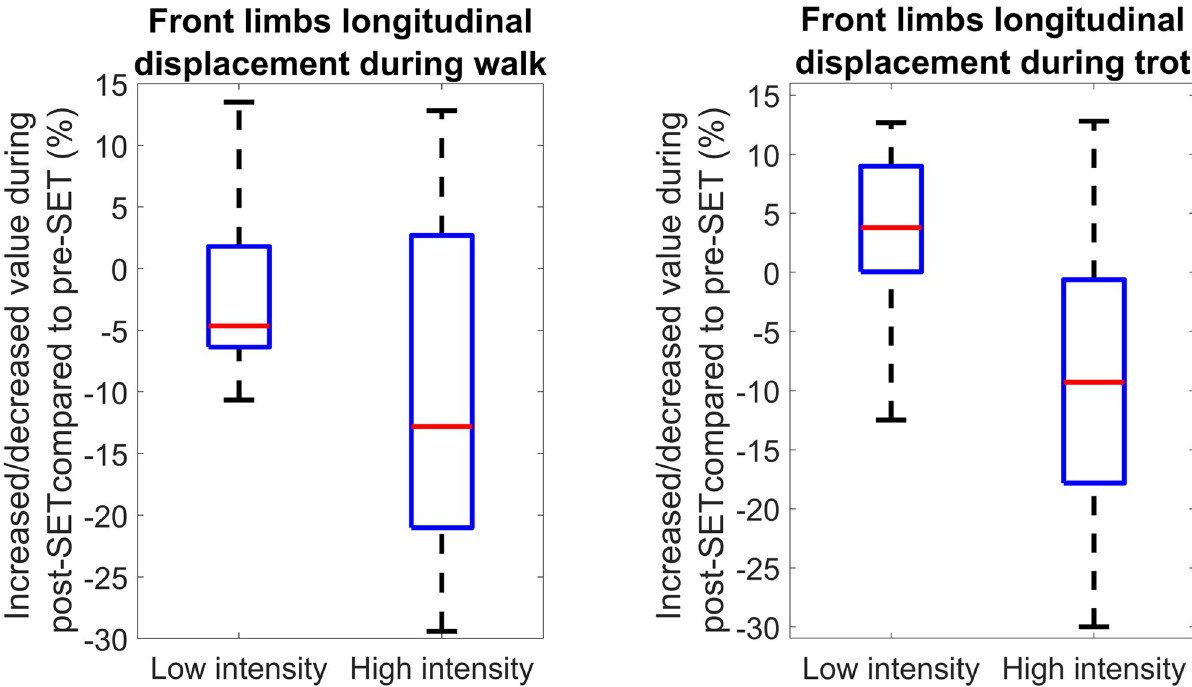
Fig 6. Comparison of biomechanical features between low and high intensity SETs (datasets 2 and 3) during walk and trot. The vertical axis represents the increase/decrease percentage of feature value during post-SET compared to pre-SET. The box represents the interquartile range, while the red line (horizontal line within the box) shows the median value. Each box (two for each plot) consists of one value per horse, which was averaged from all strides of the horse.